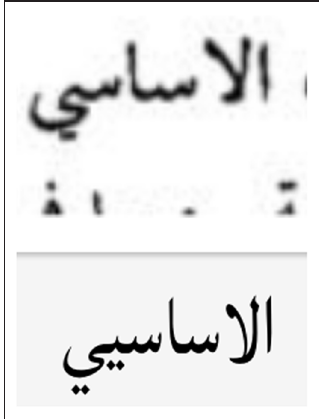
Figure 4: “Doubled Letter”